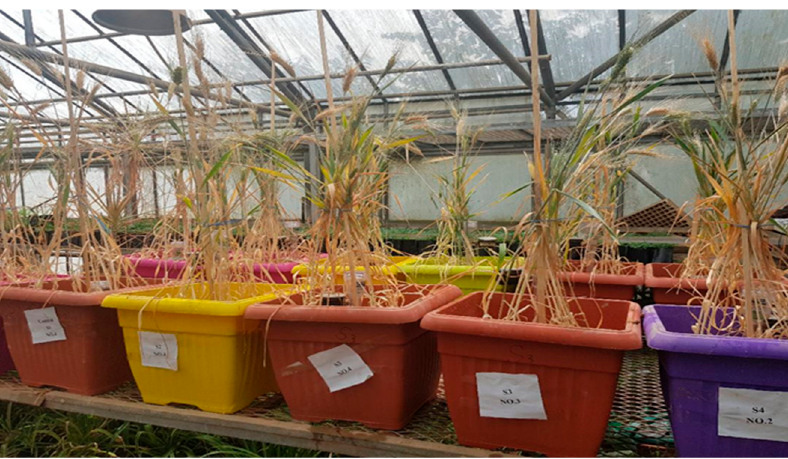
Figure 2. Harvesting at greenhouse experiment in April 2018.